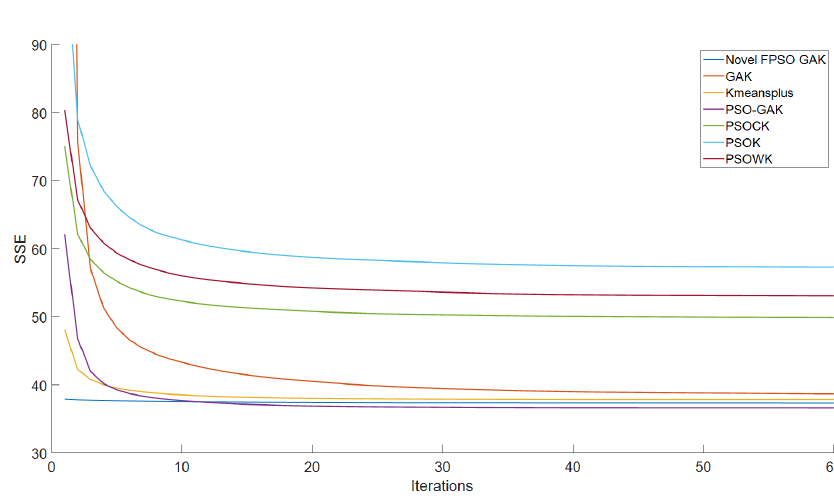
Figure 13. The SSE convergence curve of taxi GPS dataset from San Francisco